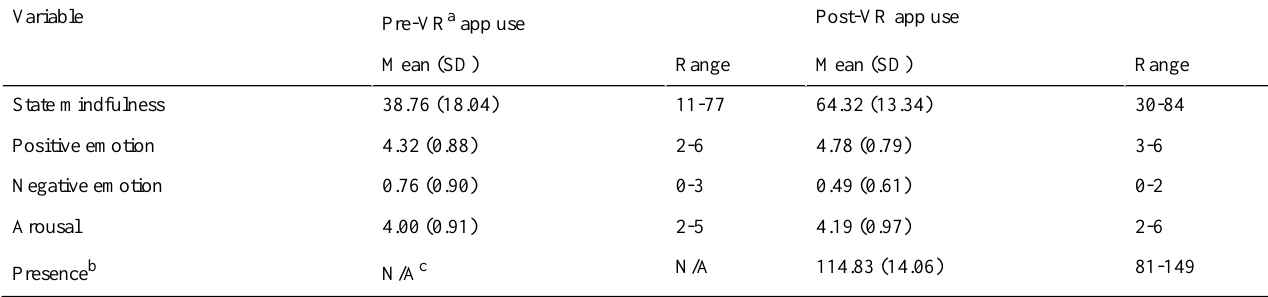
Table 1. Descriptive statistics of primary outcomes pre- and post use of the virtual reality mindfulness app.